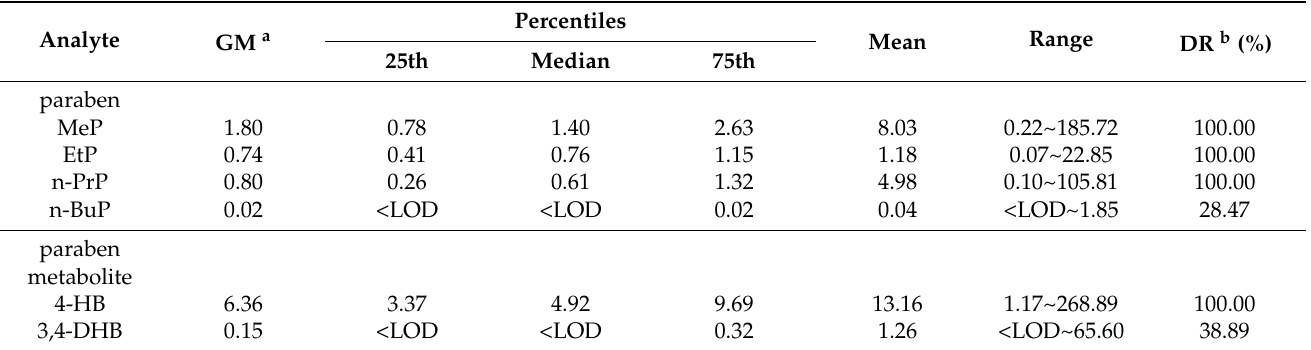
Table 4. Concentrations (ng/mL) of parabens and their metabolites in seminal plasma samples ( n =